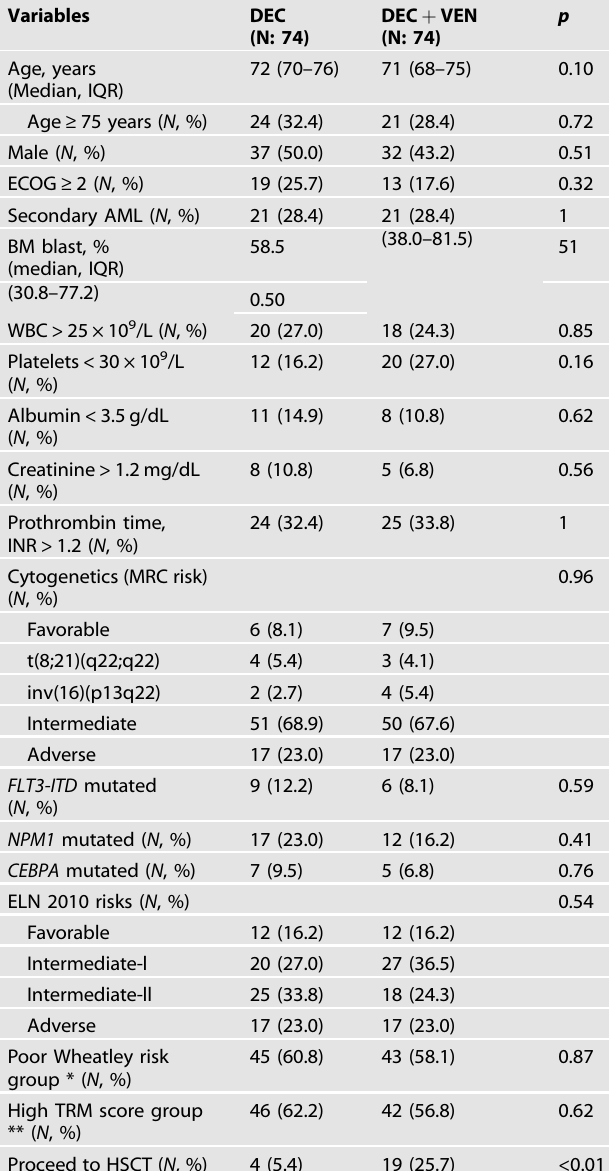
DEC + VEN group than in the DEC group (30-day mortality: 0% vs. 17.9%, p = 0.02; 60-day mortality: 0% vs. 28.6% p < 0.01). However, the early mortality rate did not differ between the groups for high TRM risk patients (30-day mortality: 4.8% vs. 4.3%, p = 1.0; 60-day mortality: 16.7% vs. 13.0%, p = 0.77). Survival outcomes The median follow-up of the patients in the DEC + VEN group and DEC group was 8.3 months and 8.5 months, respectively, and the median follow-up of surviving patients in each group (DEC + VEN, n = 37; DEC, n = 7) was 11.5 months and 22.3 months. OS was signi fi cantly longer in the DEC + VEN group than in the DEC group (median OS: 13.4 months vs. 8.3 months, hazard ratio [HR]: 0.60, 95% con fi dence interval [CI]: 0.40 – 0.91, p = 0.01, Fig. 1A). We also compared the OS censored at the time of the HSCT since